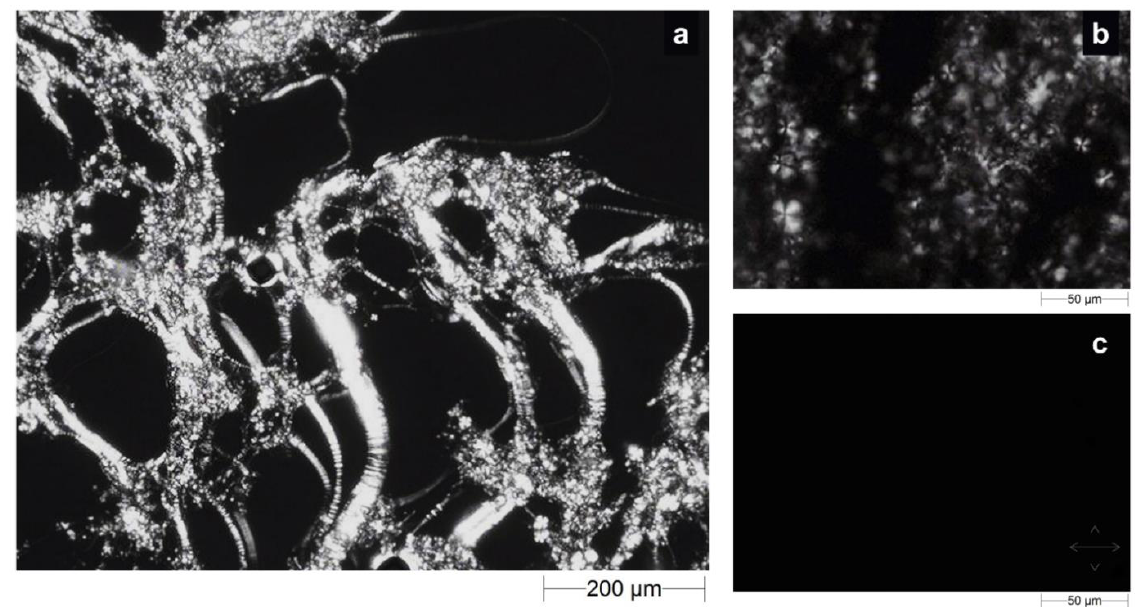
Figure 4. Optical micrographs obtained by CPLM analysis of the drug-loaded precursor solution at ( a ) 5 × and ( b ) 20 × magnifications and the corresponding cubic phase ( c ) obtained after swelling in SVF. Crossed white double arrows indicate the orientation of polarizer filters.